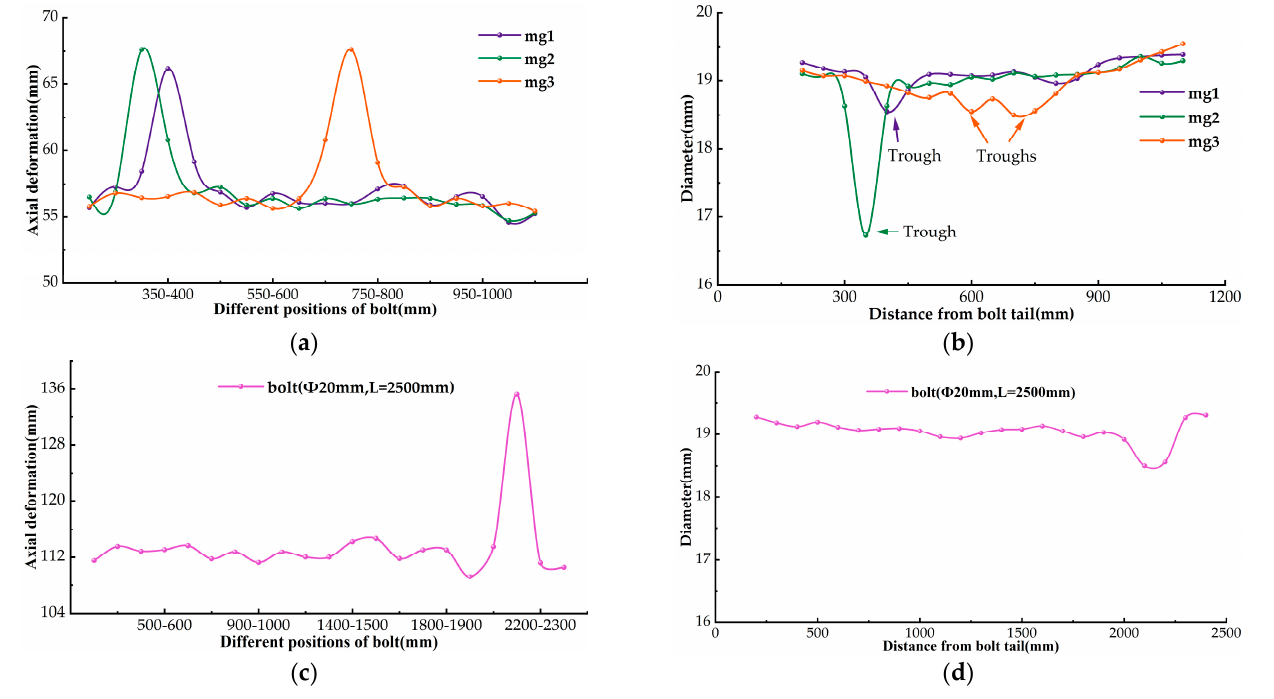
Figure 5. Axial ( a , c ) and radial ( b , d ) deformation curves of different parts of bolts. Bolt length: ( a ) 1200 mm; ( b ) 1200 mm; ( c ) 2500 mm; ( d ) 2500 mm.